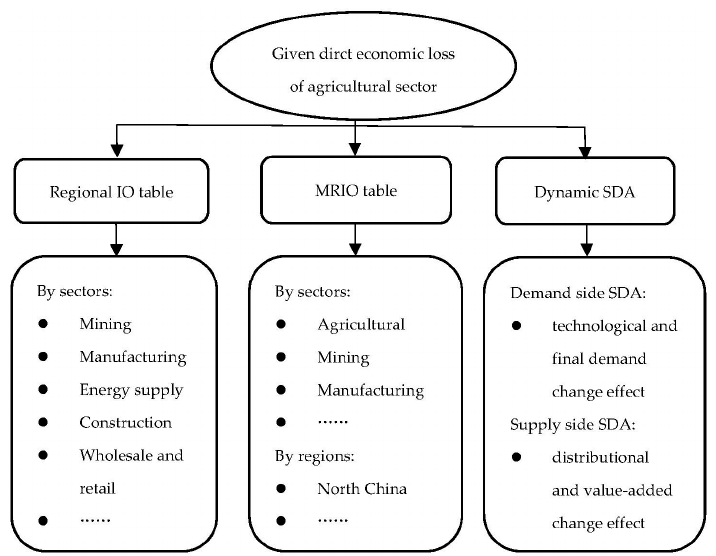
Figure 1. A brief exhibition of the methodology to calculate indirect economic losses.